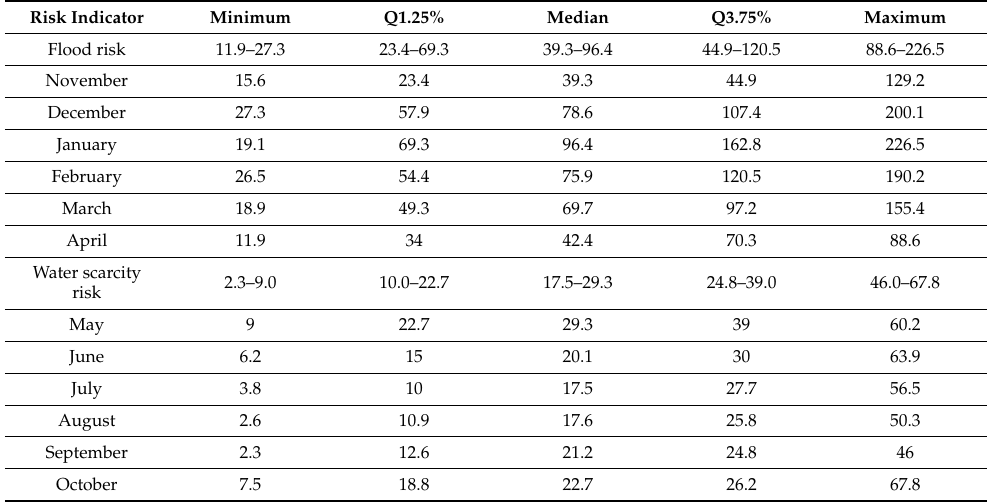
Table 9. Flood risk and water scarcity risk by month flow (m 3 /s) for the Alberto Flores fluviometric station determined from the monthly variation flow simulated.